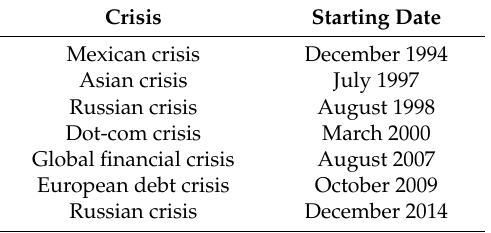
Table 10. Crisis’ starting dates of the worst recent crisis. Source: Authors’